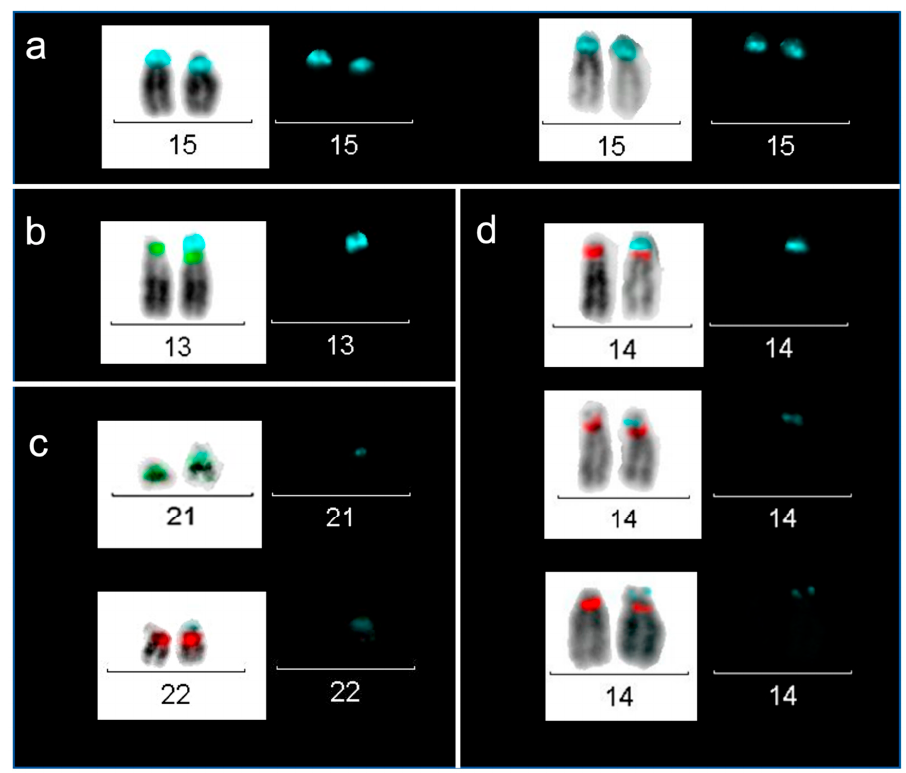
Figure 2. Hybridization of D15Z1 on acrocentric p arms of acrocentric chromosomes. We used probe D13Z1/D21Z1 in spectrum green, probe D14Z1/D22Z1 in spectrum red and probe D15Z1 in spectrum aqua. Left, merged images of 4’,6-diamidino-2-phenylindole (DAPI) bands in greys and triple-band filter fluorescence; right D15Z1 signal observed with aqua single-band filter. ( a ). Chromosomes 15 showing the normal D15Z1 signal; ( b ). One D15Z1 signal on chromosome 13p; ( c ). One D15Z1 signal on G chromosomes 21p and 22p; and, ( d ). One D15Z1 signal on chromosome 14p, and examples of the different sizes of the extra